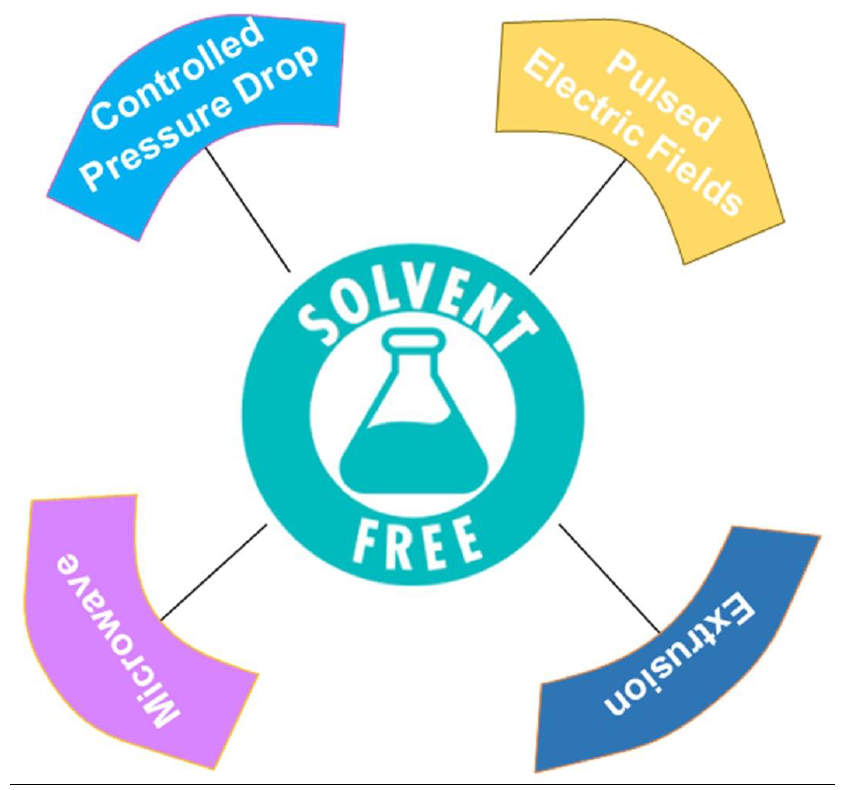
Figure 5. Different solvent-free extraction technologies.